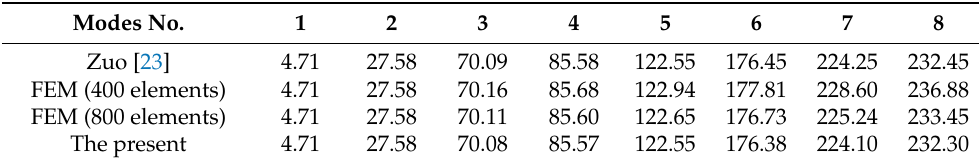
Table 1. Comparison of the natural frequency with literature.